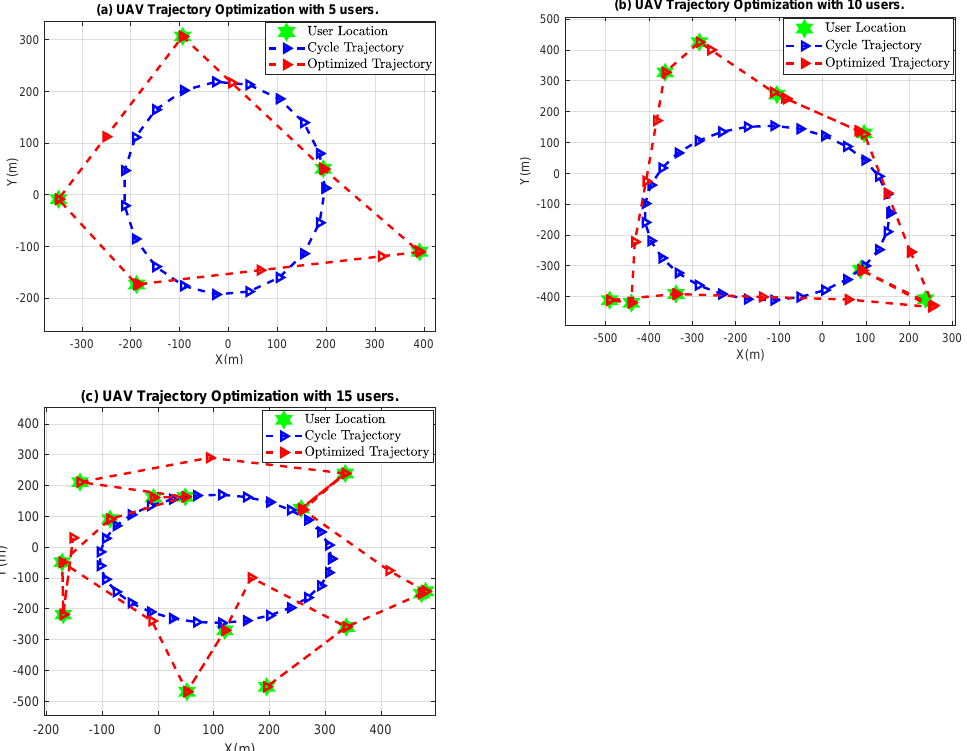
Figure 2. UAV Trajectory optimization with different number of users in the system.